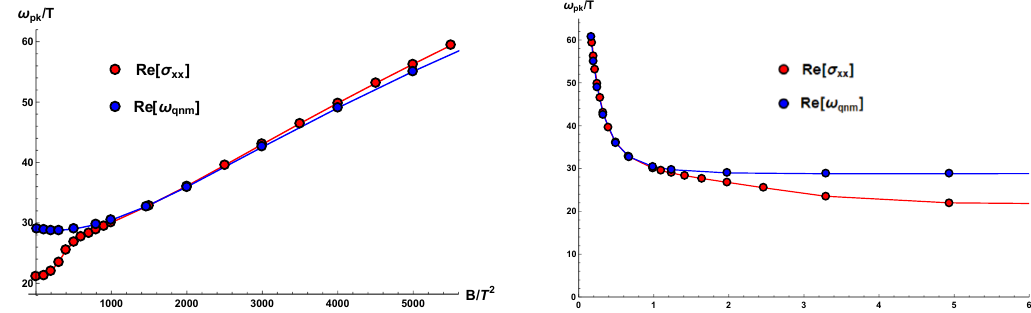
Figure 19 . Dependence of the peak position ! pk as a function of the magnetic (cid:12)eld B=T 2 and the (cid:12)lling fraction (cid:23) (cid:17) (cid:26)=B . The peak is extracted both from the real part of the longitudinal conductivity (red dots) and from the quasinormal modes spectrum (blue dots).